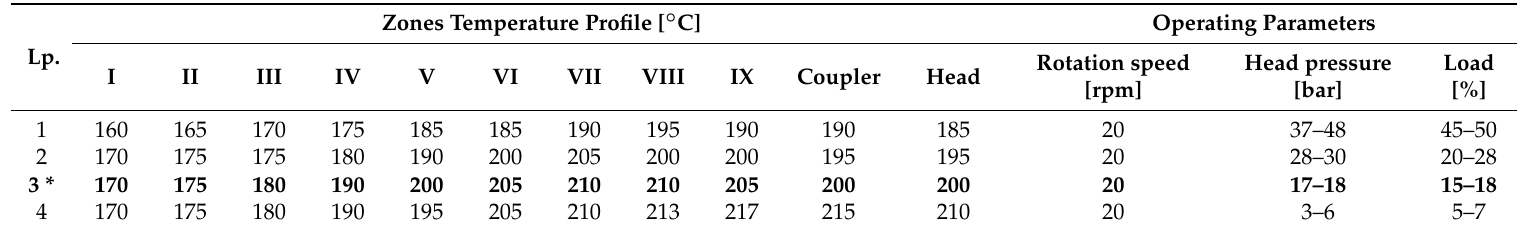
Table 2. Process parameters of F-TPU filament